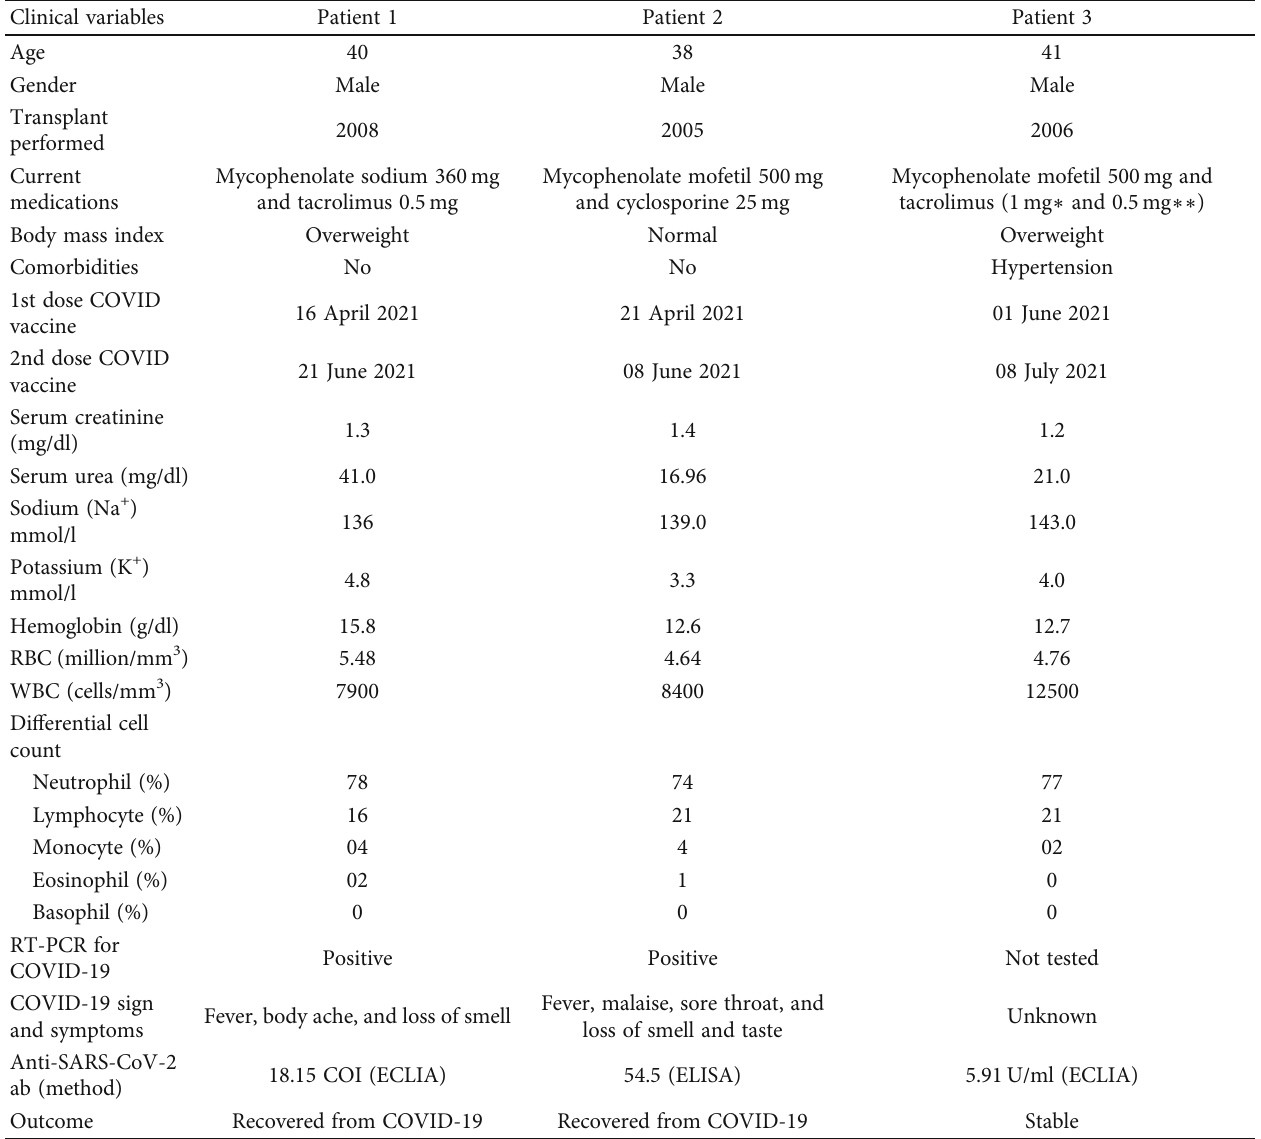
Table 1: Di ff erent variables of the three renal transplant